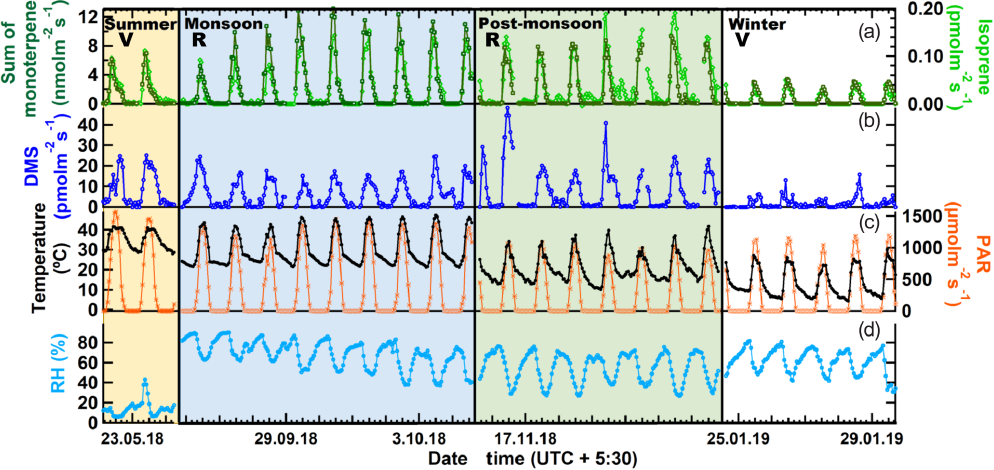
Figure 2. BVOC emission fluxes (expressed in nanomols or picomols per square meter of leaf area per second) along with PAR and temper- ature and relative humidity. R: Reproductive growth phase. V: Vegetative growth